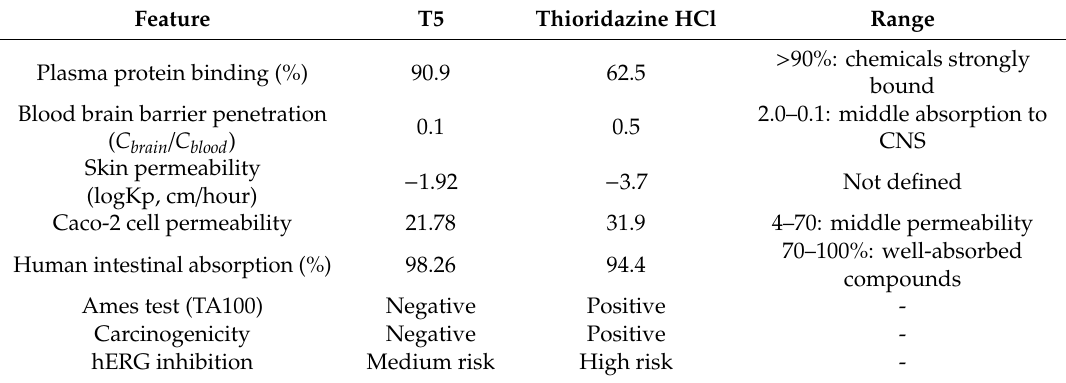
Table 2. In silico predictions of T5 and thioridazine HCl.